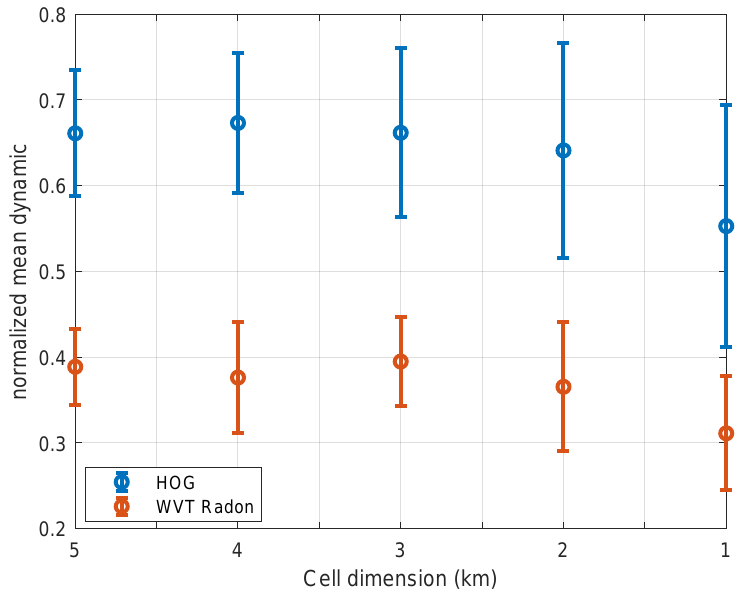
Figure 18. HOG and WVT Radon dynamics in function of cell